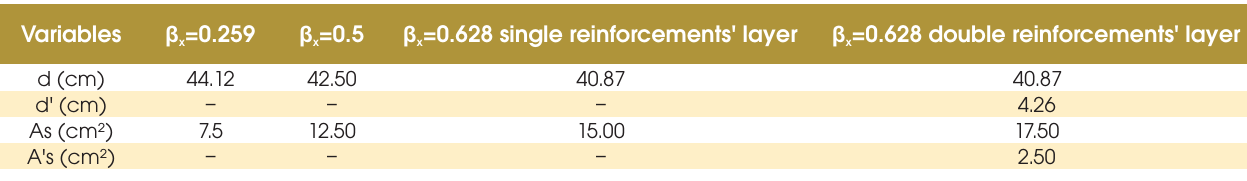
Table 1 – Results of the design of the reinforced concrete beam analyzed